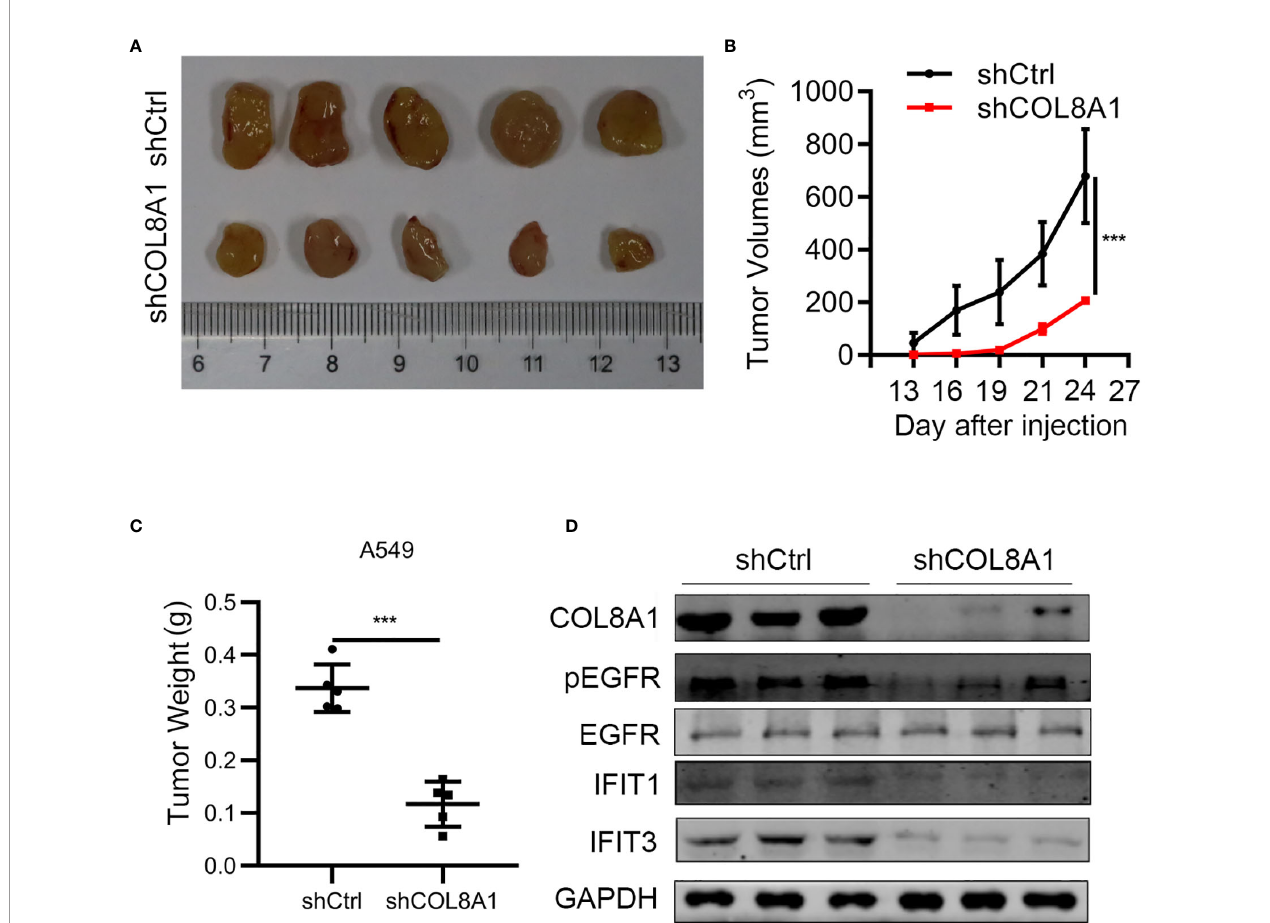
FIGURE 6 | COL8A1 contributes to NSCLC progression by activating EGFR in vivo . BALB/c nude mice were subcutaneously transplanted with COL8A1-silenced NSCLC cells. Mice were sacri fi ced 5 weeks after implantation. (A) Macroscopic images of xenografted tumors. (B) Tumor growth curves. (C) Tumor weight was determined immediately after sacri fi cing the mice. (D) Tumor tissues were subjected to western blotting analysis with the indicated antibodies. ***p <